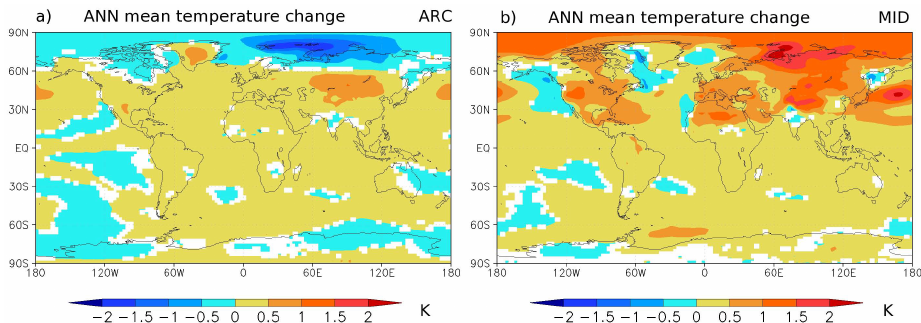
Fig. 7. Annual mean surface air temperature change (in K) for (a) the ARC-CONTROL and (b) the MID-CONTROL. White areas are not significant on a 95% level.